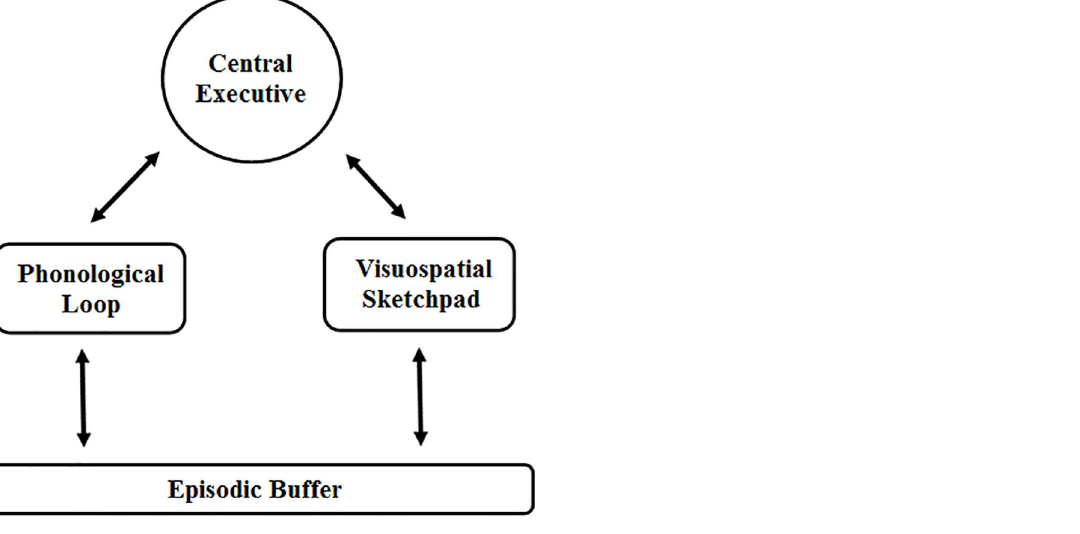
Figure 1. Basic theoretical framework for this review (based on Baddeley,